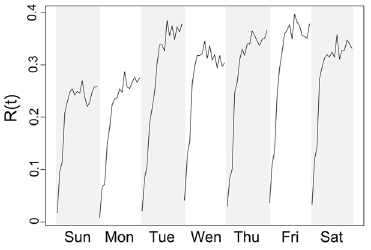
Figure 4. Regularity with which each participant was found at his/her most visited location over a typical week ( R(t) ) from 7:00AM to 11:00PM. A high value of R(t) indicates that individuals spent a significant proportion of their time at the most visited location (equivalent to work or school, where people could spend between 6 and 8 hours every